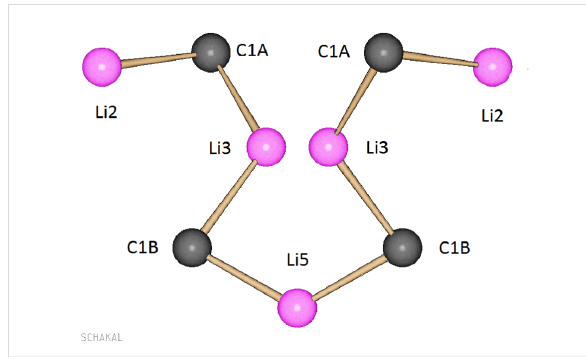
Figure 3: The C 2 symmetric carbon–lithium chain of aggregate ( 2a ) 4 ·(THF) 6 in the crystal (color code: black, C; pink, Li). All atoms except C1A, C1B, Li2, Li3, and Li5 are omitted for clarity.